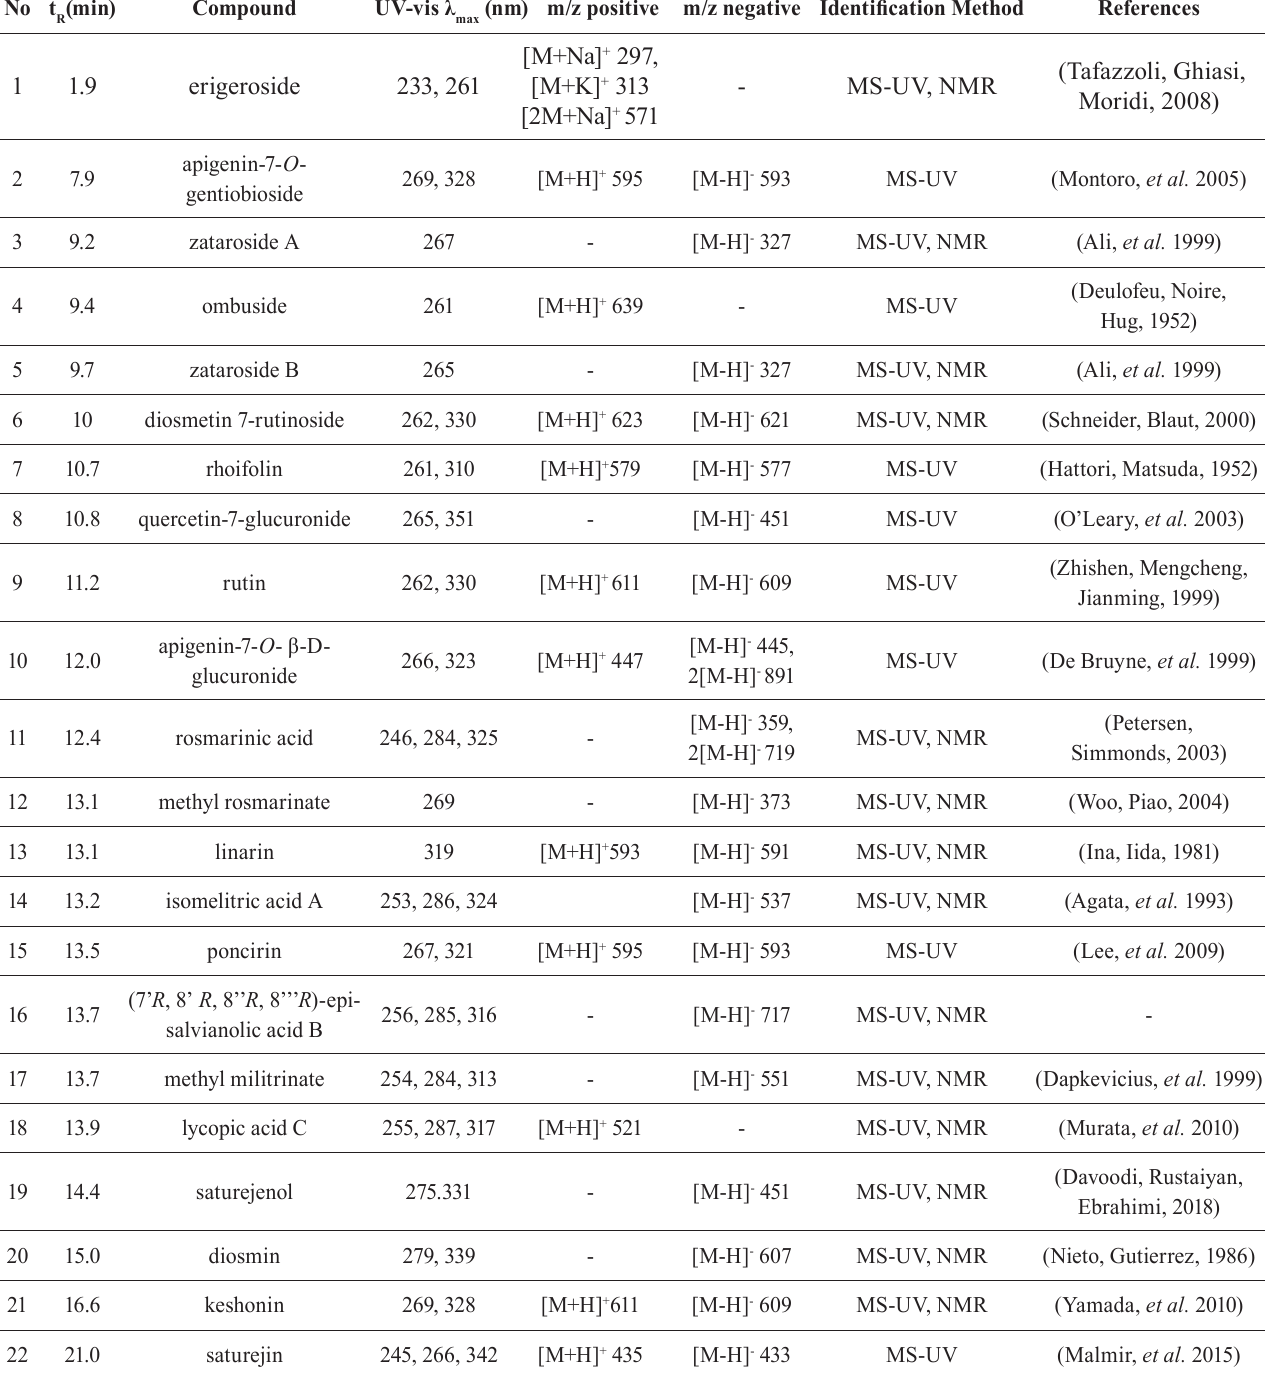
TABLE I - L ist of identified compounds from methanolic extract of S.